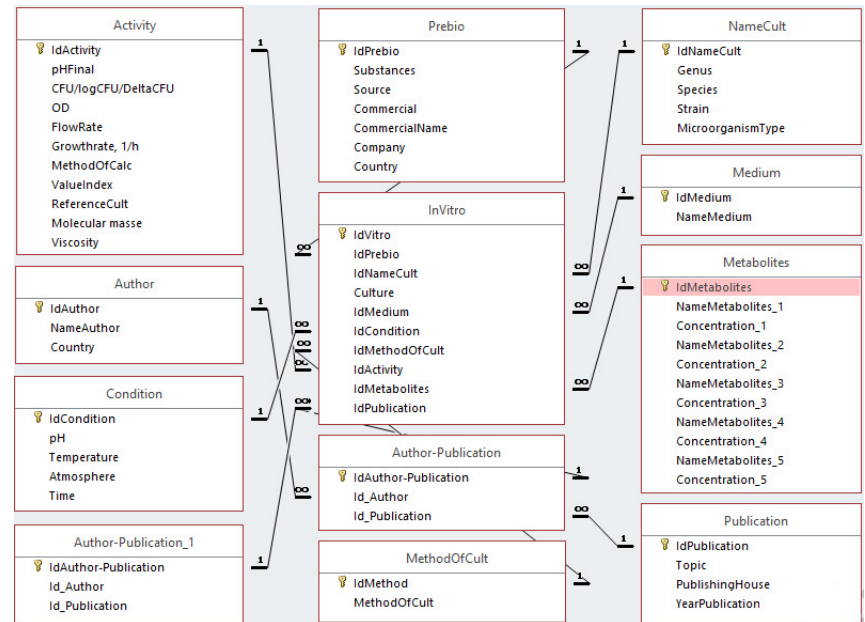
Figure 1. Infological diagram of the database, which reflects the relation between all data groups (1 means one parameter from one group, ∞ means many different parameters from another group, for example, one medium can be applied for the fermentation for different prebiotic